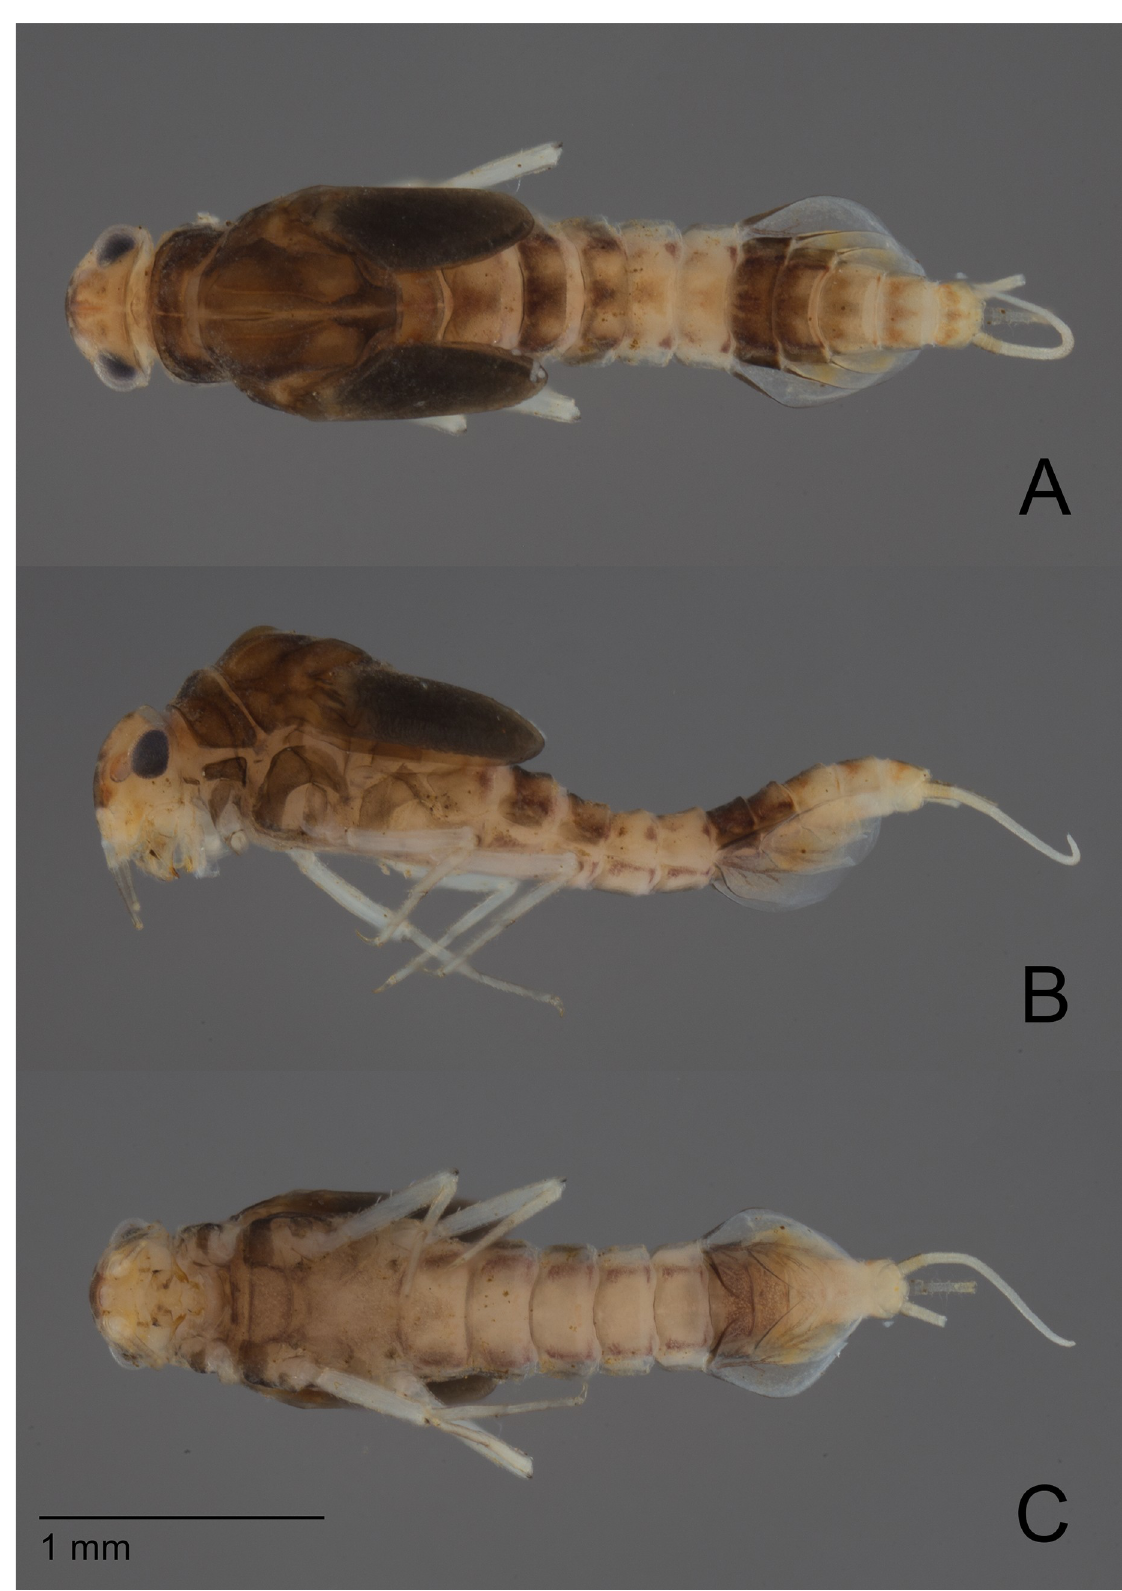
Fig 1. Cymbalcloeon sartorii gen. nov. et sp. nov. Female mature larva. (A) dorsal view, (B) lateral view, (C) ventral view. https://doi.org/10.1371/journal.pone.0240635.g001 PLOS ONE | https://doi.org/10.1371/journal.pone.0240635 October 13,